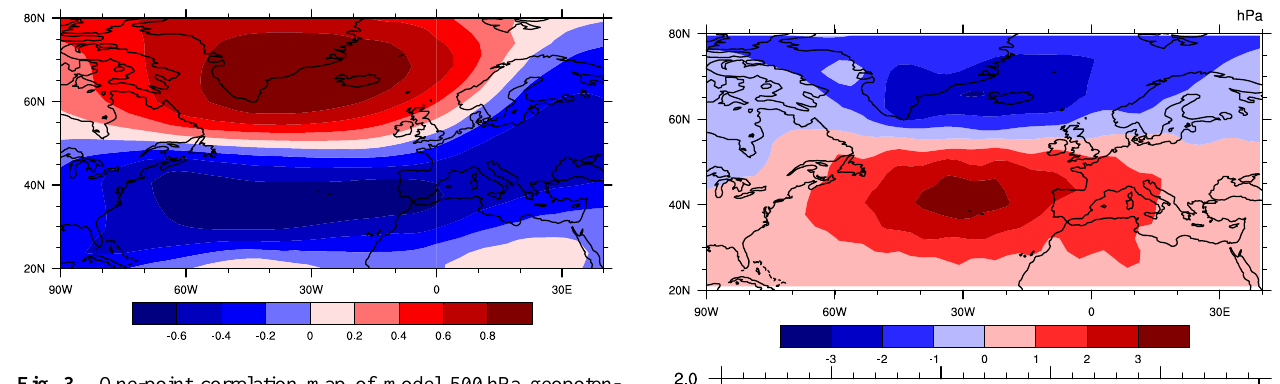
level pressure (SLP) anomalies field (Fig. 4, top) explains